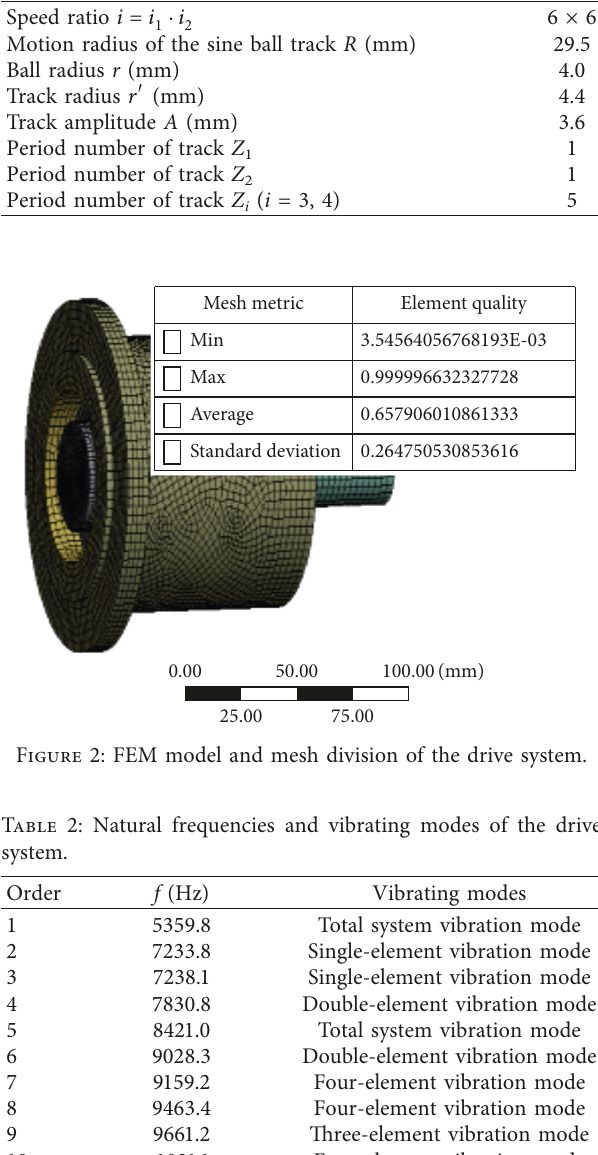
Table 1: Main parameters for the two-step sine movable tooth drive.